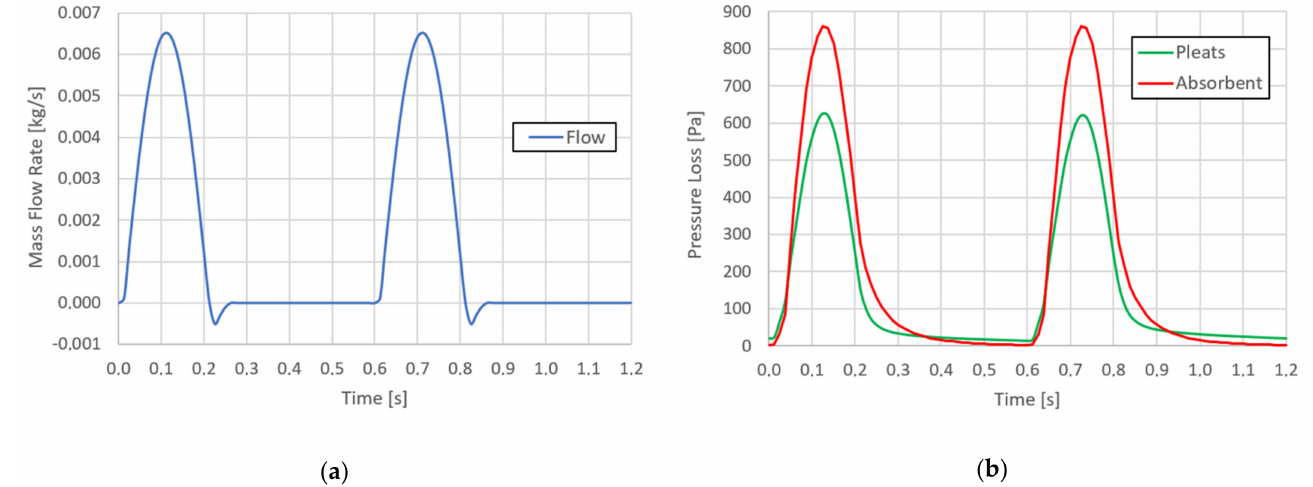
Figure 23. Breath-responsive flow. The pleat height is 13.5 mm and the spacing is 2 mm. Mass flow corresponds to continuous flow 70 L/min. ( a ) Mass flow rate through filter; ( b ) Pressure loss in pleated filter and absorbent